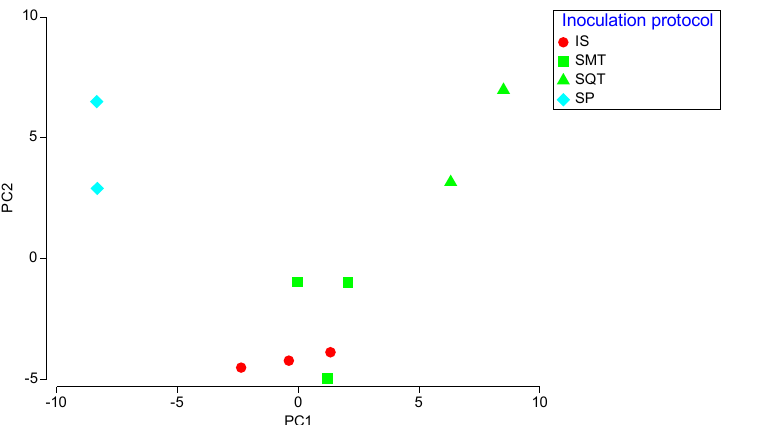
Figure 6. Principal Component Analysis (PCA) of the chemical characteristics of the pilot-scale produced wines. IS: S. cerevisiae ScS13; SMT: T. delbrueckii TdS6 and S. cerevisiae ScS13 added simultaneously; SQL: T. delbrueckii TdS6 and S. cerevisiae ScS13 added sequentially; SP: spontaneous fermentation. Table 5. Chemical parameters of wines produced in pilot scale fermentations (mean ± SD, n = 2 or n = 3 in IS and SMT). Values not sharing a letter are significantly different ( p < 0.05).